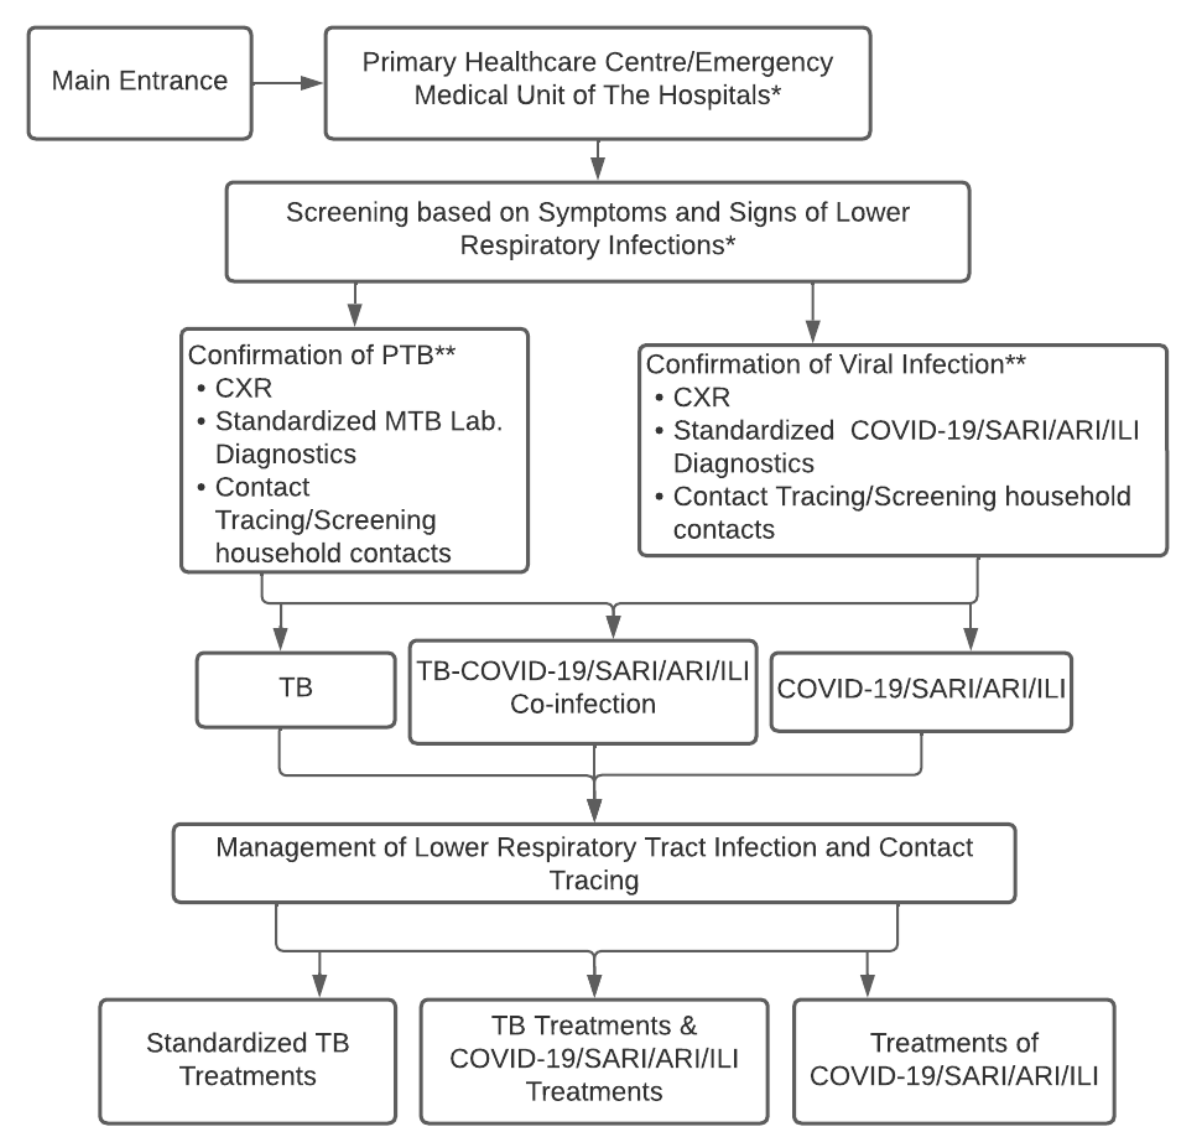
Figure 1. Conceptual Algorithm of TB-COVID-19 Integrated Management in Healthcare Figure 1 . Conceptual Algorithm of TB-COVID-19 Integrated Management in Healthcare Facilities.